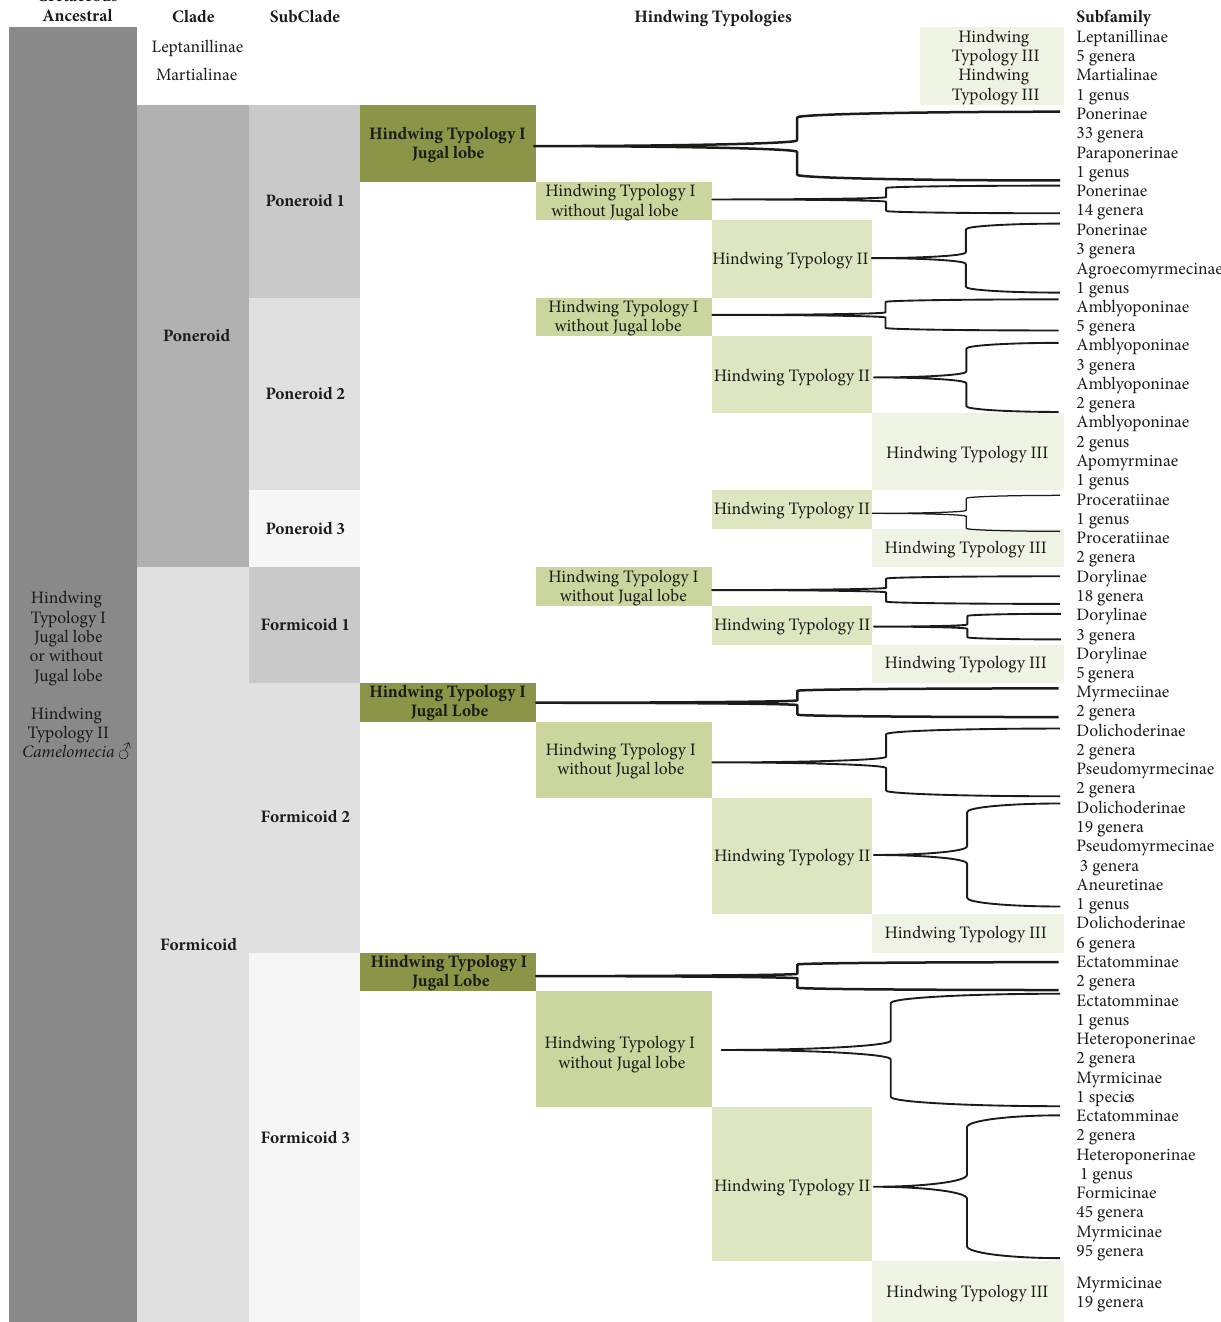
Figure 6: Analysis of the hindwings Typologies, in each Clade and Subclade, with the corresponding numbers of genera in each